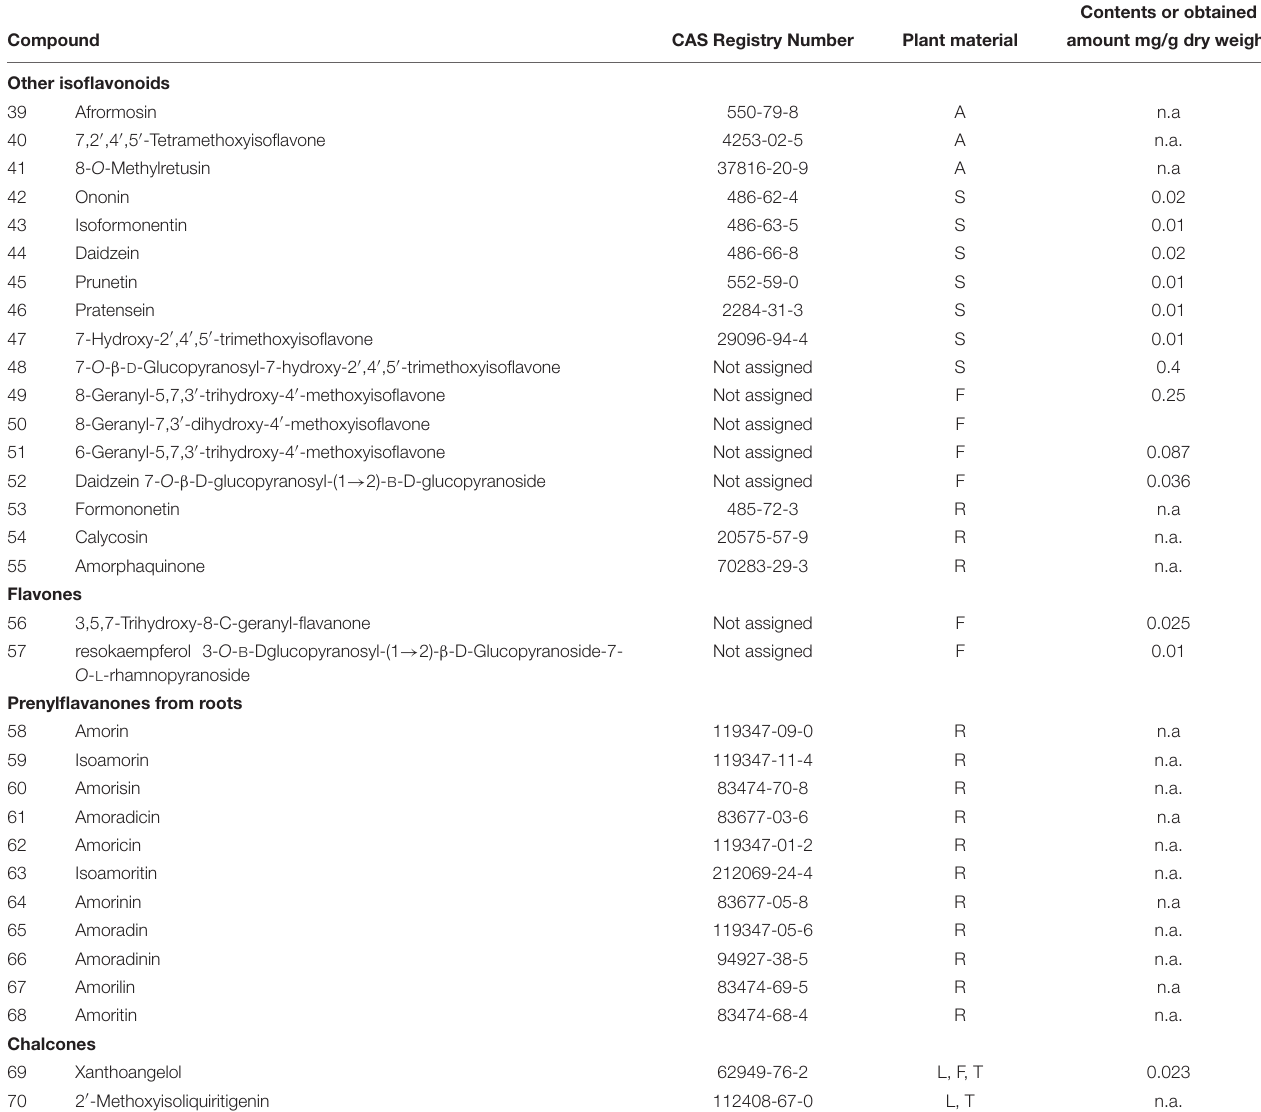
TABLE 2 | Isoflavonoids (non-rotenoid) and other flavonoids isolated from various parts of Amorpha fruticosa